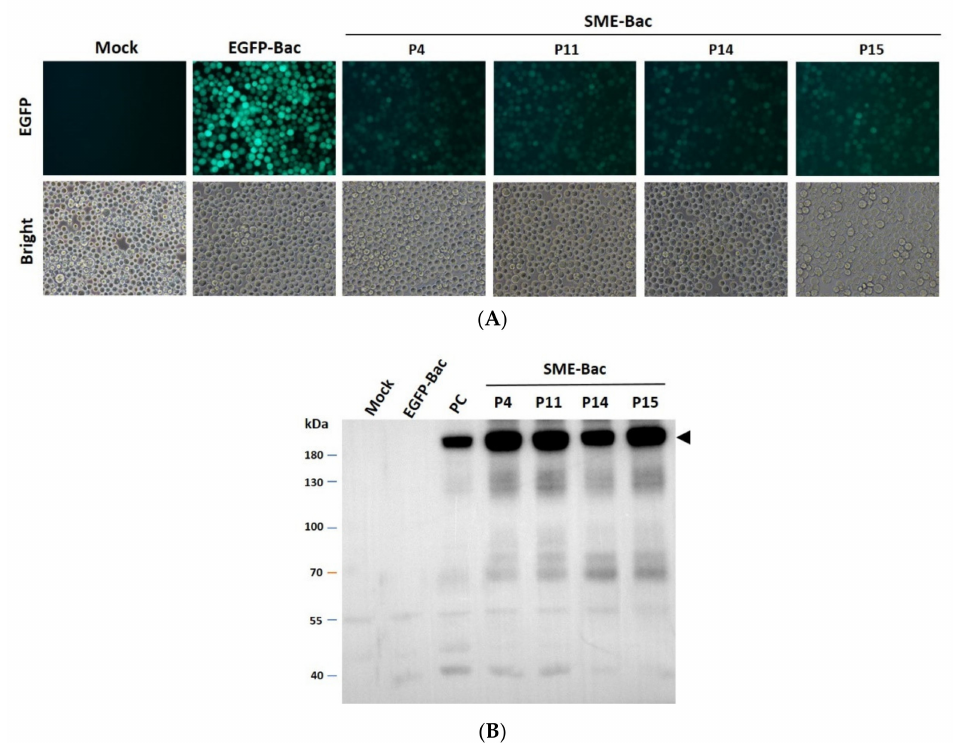
Figure 4. Detection of PEDV spike protein expression in Sf21 cells infected with di ff erent passages of SME-Bac. ( A ) The expression level of EGFP of Sf21 cells infected with 1 MOI of EGFP-Bac or SME-Bac passages 4, 11, 14, or 15 (P4, P11, P14, or P15) for 4 days were observed by